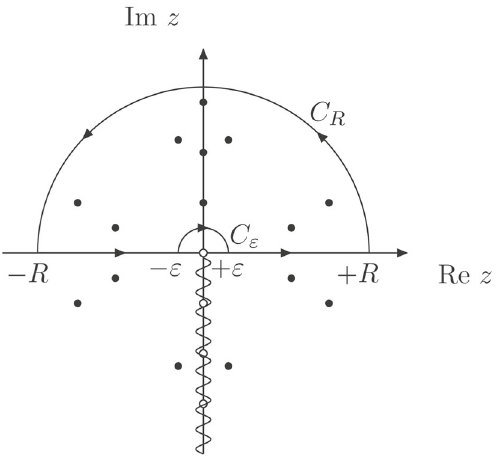
Fig. 2 Contour of integration used to evaluate (78), poles and branch cut defined by